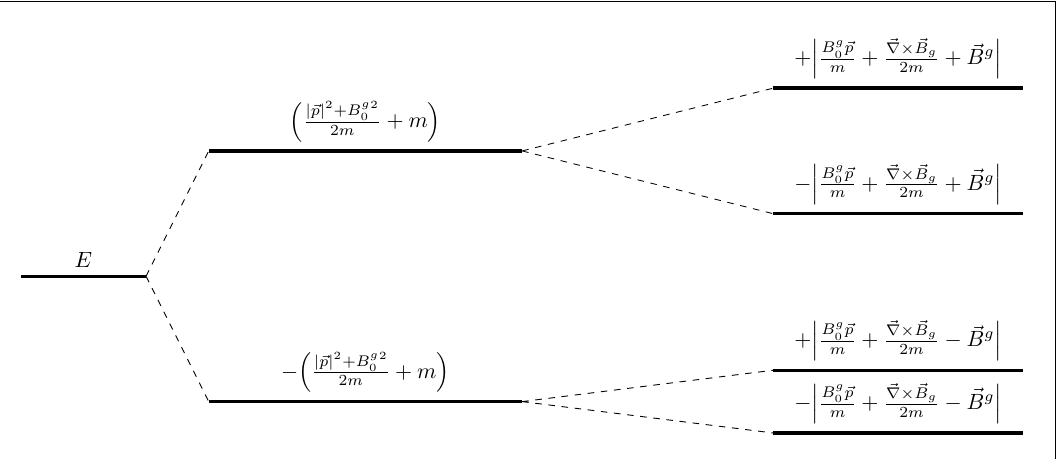
Figure 2. Gravitational